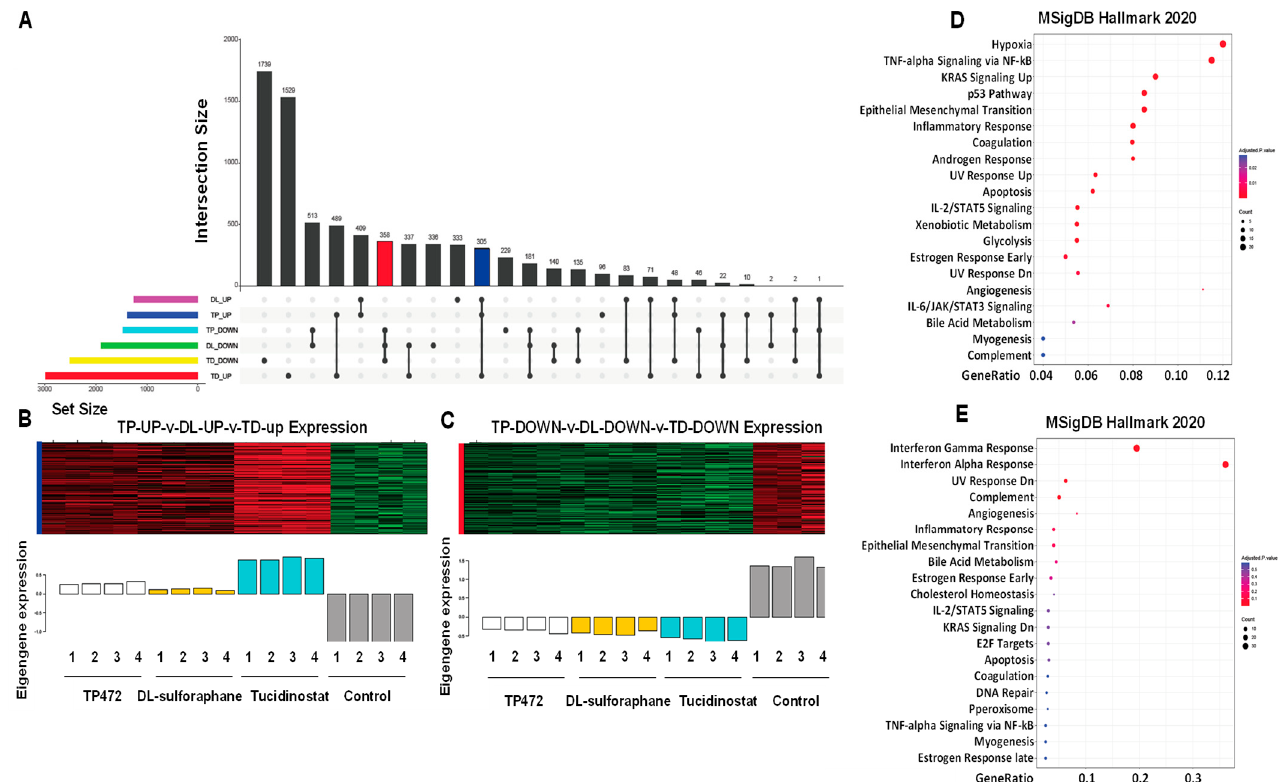
Figure 13. Intersection size of DEGs across Tucidinostat, DL − sulforaphane, and TP472 treatments and associated epigenetic changes . ( A ) Upset diagram showing the intersection size of upregulated and downregulated genes across drug treatments. ( B ) Eigengenes expression pattern in the blue intersection. ( C ) Eigengenes expression pattern in the red intersection. ( D , E ) The dot plot of the top 20 functional enrichment results for ( D ) blue intersection and ( E ) red intersection.